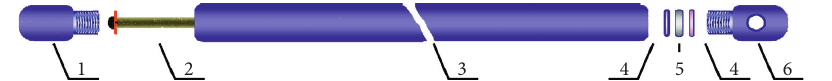
Figure 3: Structure of CO 2 cracker. 1, filling valve; 2, heating pipe; 3, main pipe; 4, sealing gasket; 5, shearing piece; 6, energy release head.